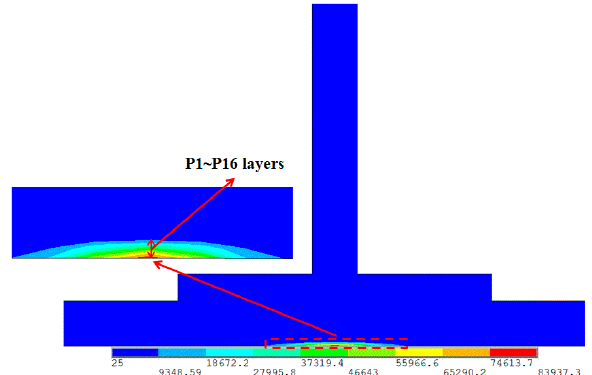
Figure 6. Temperature distribution in the cross-section of the composite reinforced panel. (Unit: °C).